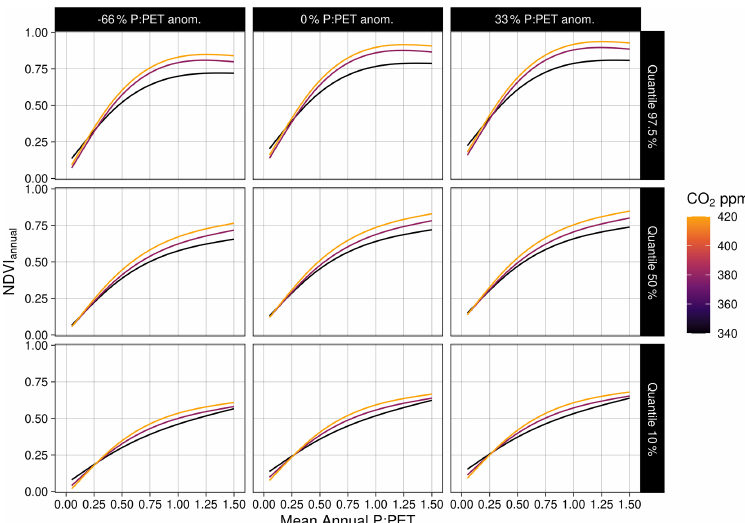
Figure A7. Quantile GAM regression predictions across CO 2 and anomalies of annual P :PET. NDVI 3mo = s( CO 2 ) + s(